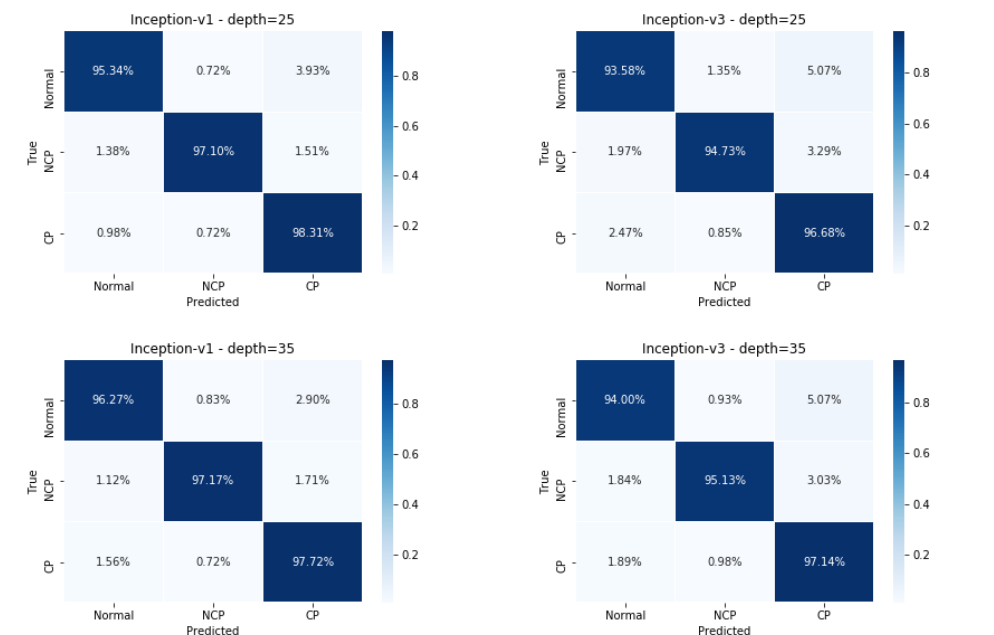
Figure 13. Soft-voting ensemble models—Normalized confusion matrices obtained for the ensemble models built using the Inception-V1 and Inception-V3 architectures for CT scans with 25 and 35 slices.